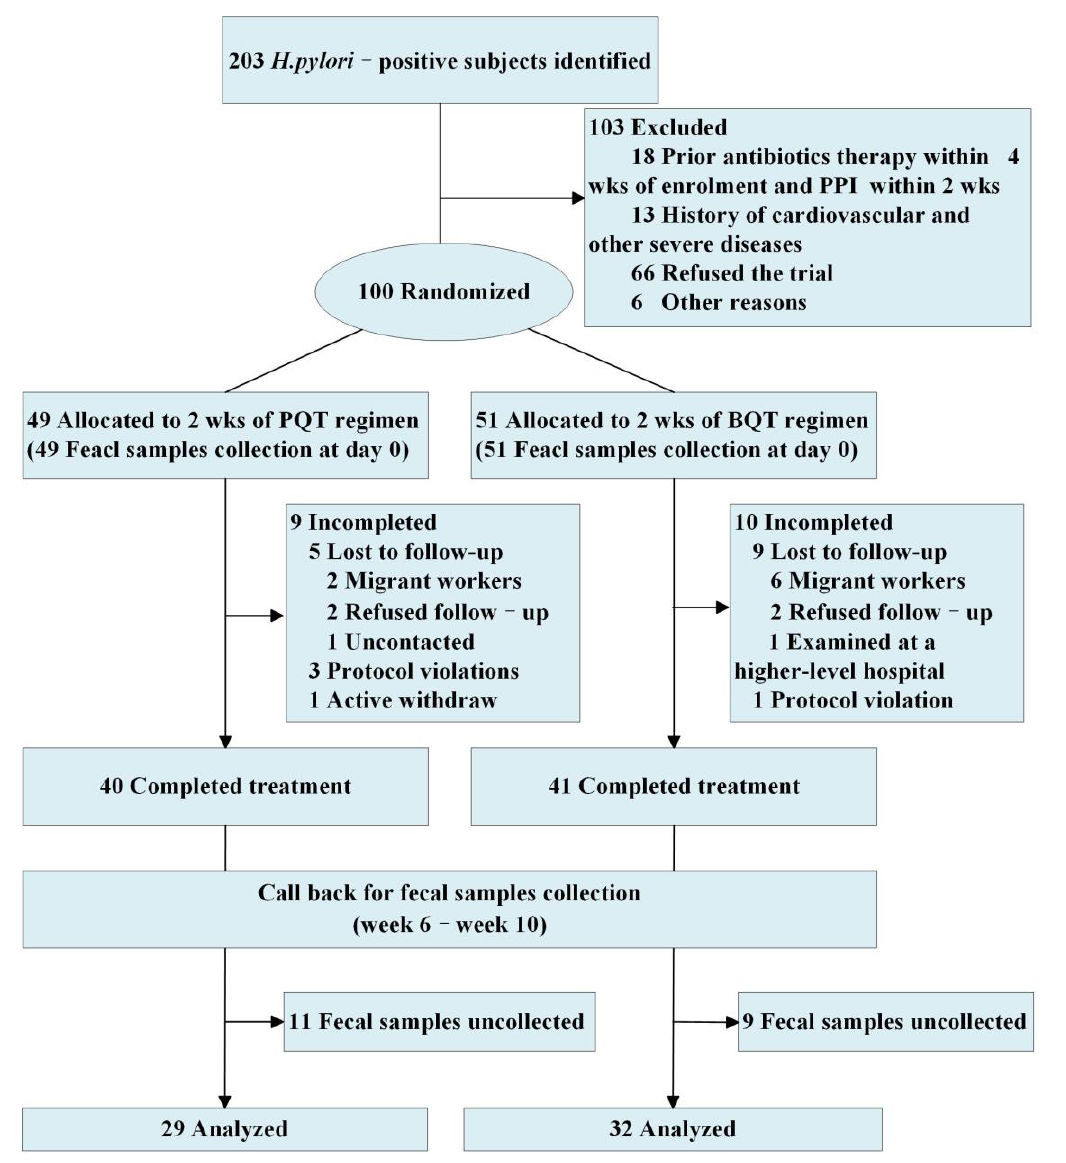
Figure 1. CONSORT flow diagram of this study. Table 1. Baseline demographic and clinical characteristics.